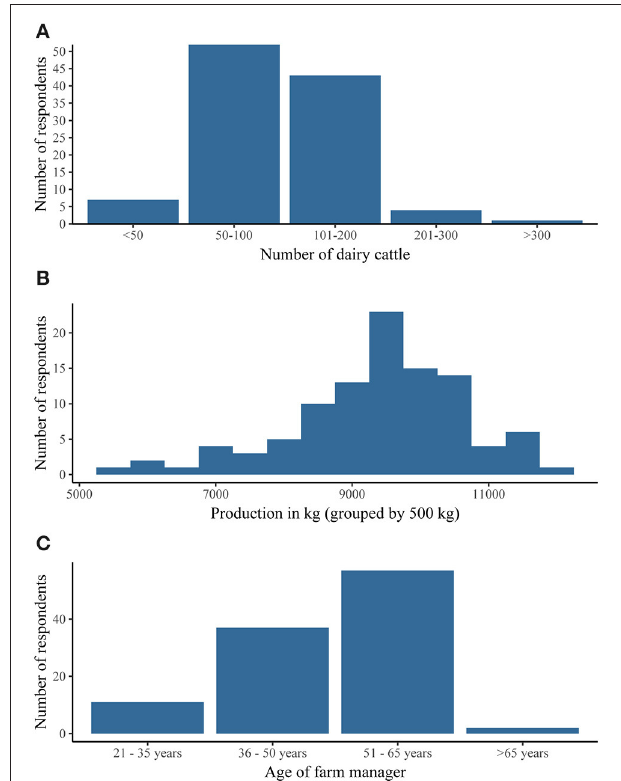
FIGURE 1 | Distribution of respondents. The number of respondents ( n = 107) grouped according to (A) herd size ( n = 107), (B) 305 days milk production ( n = 102) and (C) age of the farm manager ( n =